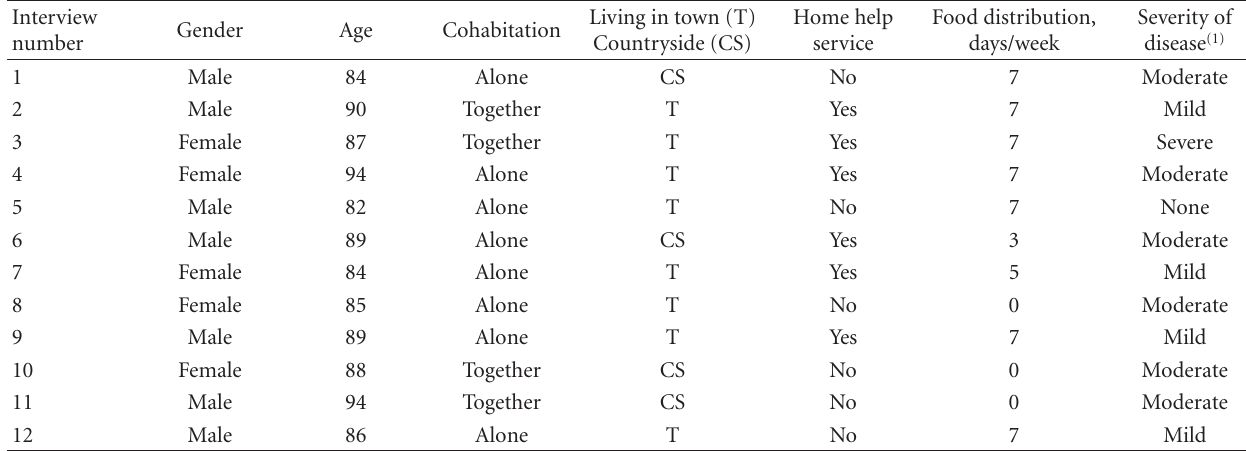
Table 1: Characteristics of the respondents.